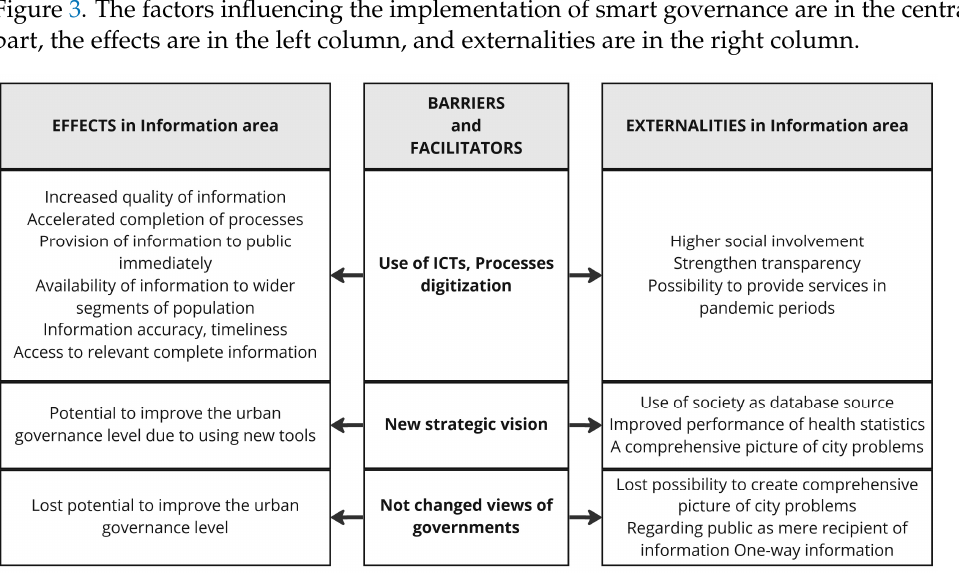
Figure 3. Barriers or facilitators, effects, and externalities of smart governance implementation in the Information area. Source: generated by the authors.